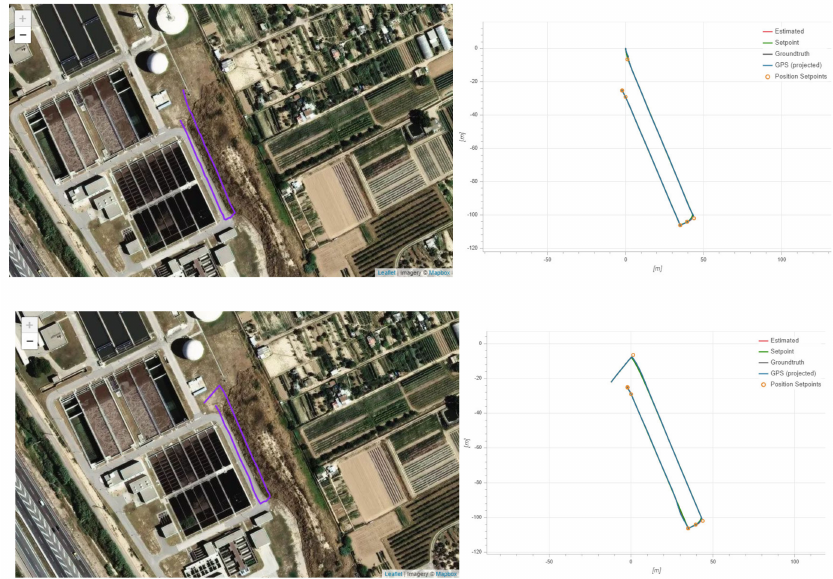
Figure 9. Two of the flights (A and B) performed in the waste water treatment installation with the UAV platform to the autonomous flight capabilities. As no external DGPS was available, the fused position estimation from the avionics system is shown as a ground